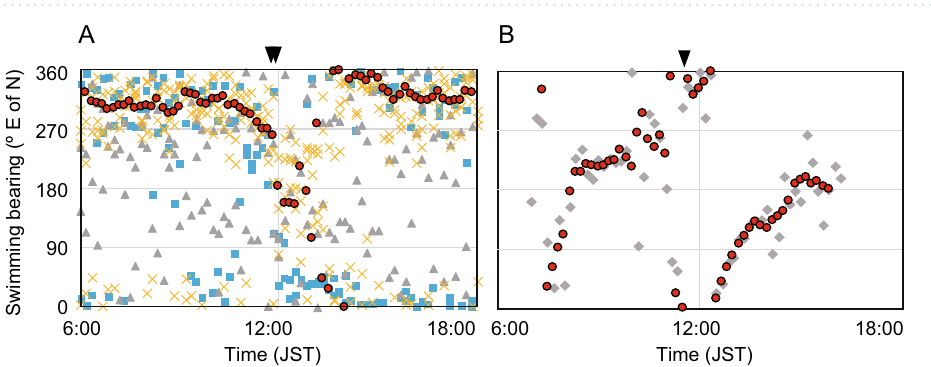
Figure 3. Time-series fluctuation of swimming bearing of four eels. ( A ) The fluctuations of swimming bearings in three eels (gray triangle WE2999_TS, blue square WE3001_TS, yellow cross WE3002_TS) released at 12°–13°N in the tropical–subtropical area around the time of Sun culmination (inverted black triangles). ( B ) The fluctuations of swimming bearings in one eel (gray diamond WE6287_KC) released at 33°N in the Kuroshio Current area changed swimming bearings around the time of solar culmination. Red circles in both figures indicate the 50 min moving average of swimming